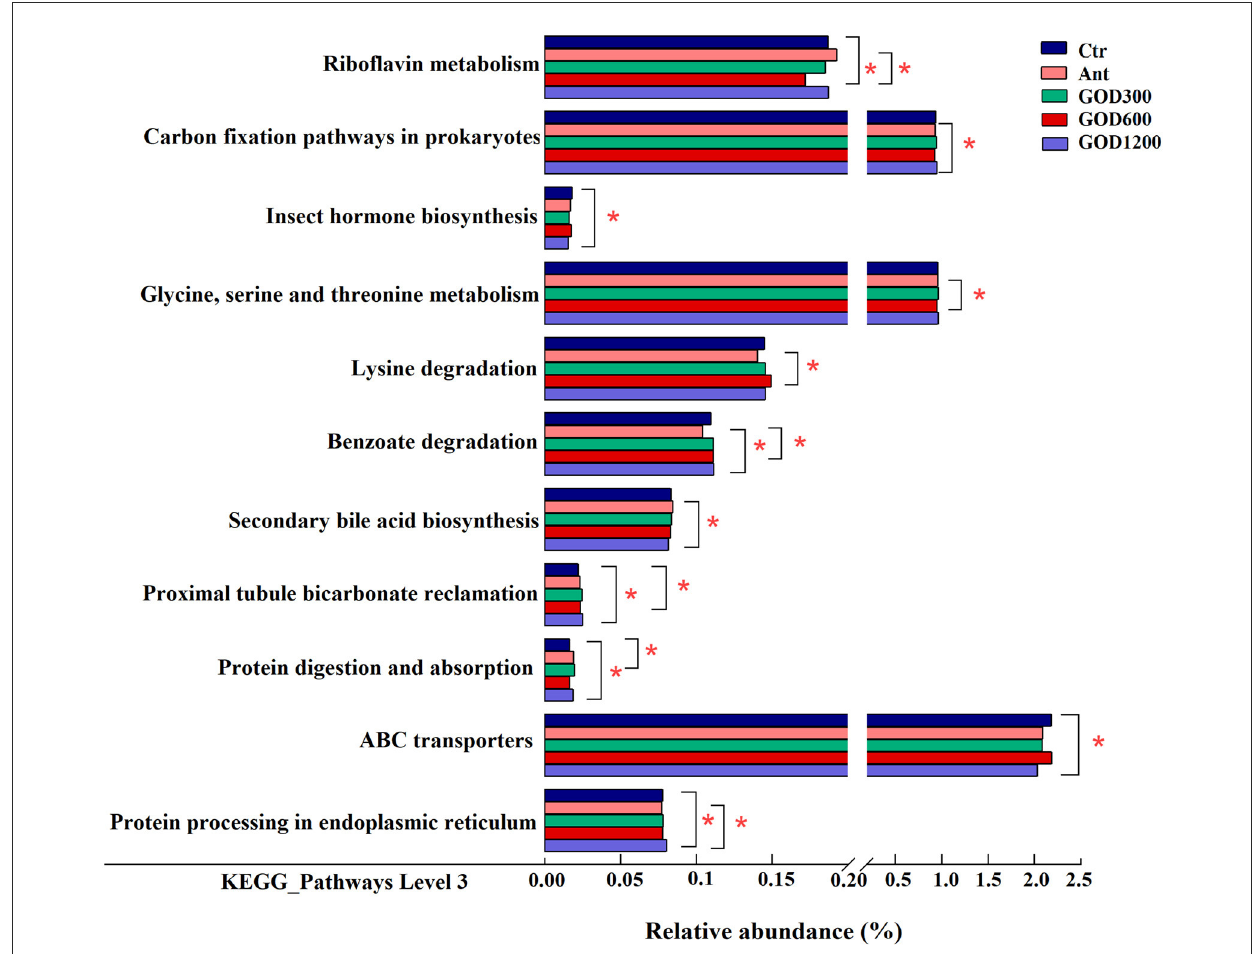
FIGURE5 The mean proportion in predicted pathways grouped into level 3 functional categories of the cecal microbiota in various treatments on day 42 ( n = 6, P < 0.05). Ctr, negative control fed with the basal diets; Ant, positive control fed with the basal diets added 50 mg/kg aureomycin; GOD300, GOD600, and GOD1200, the basal diets supplied with 300, 600, and 1,200 U/kg glucose oxidase, respectively. * Means there are significant differences in the enrichment of this pathway between the two groups. Ctr, negative control group fed with the basal diets; Ant, positive control group fed with the basal diets added 50 mg/kg